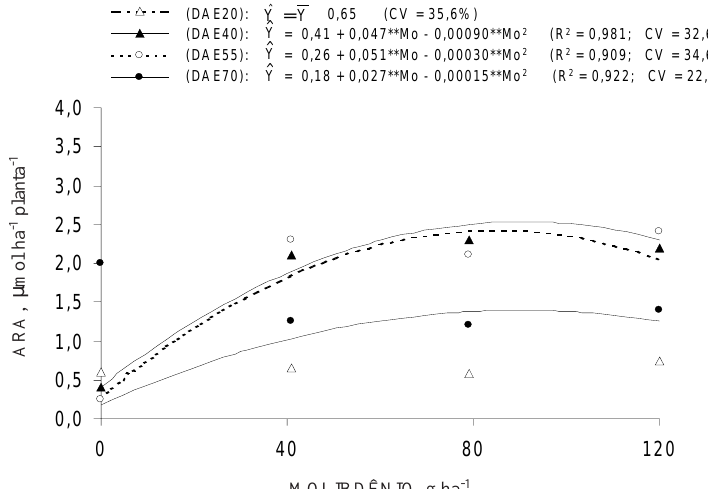
Figura 2. Atividade da enzima redutase do nitrato (ARN) aos 20, 40, 55 e 70 dias da emergência (DAE) do feijoeiro cv. Ouro Negro, considerando a adubação foliar com molibdênio. ** significativo a 1% pelo teste